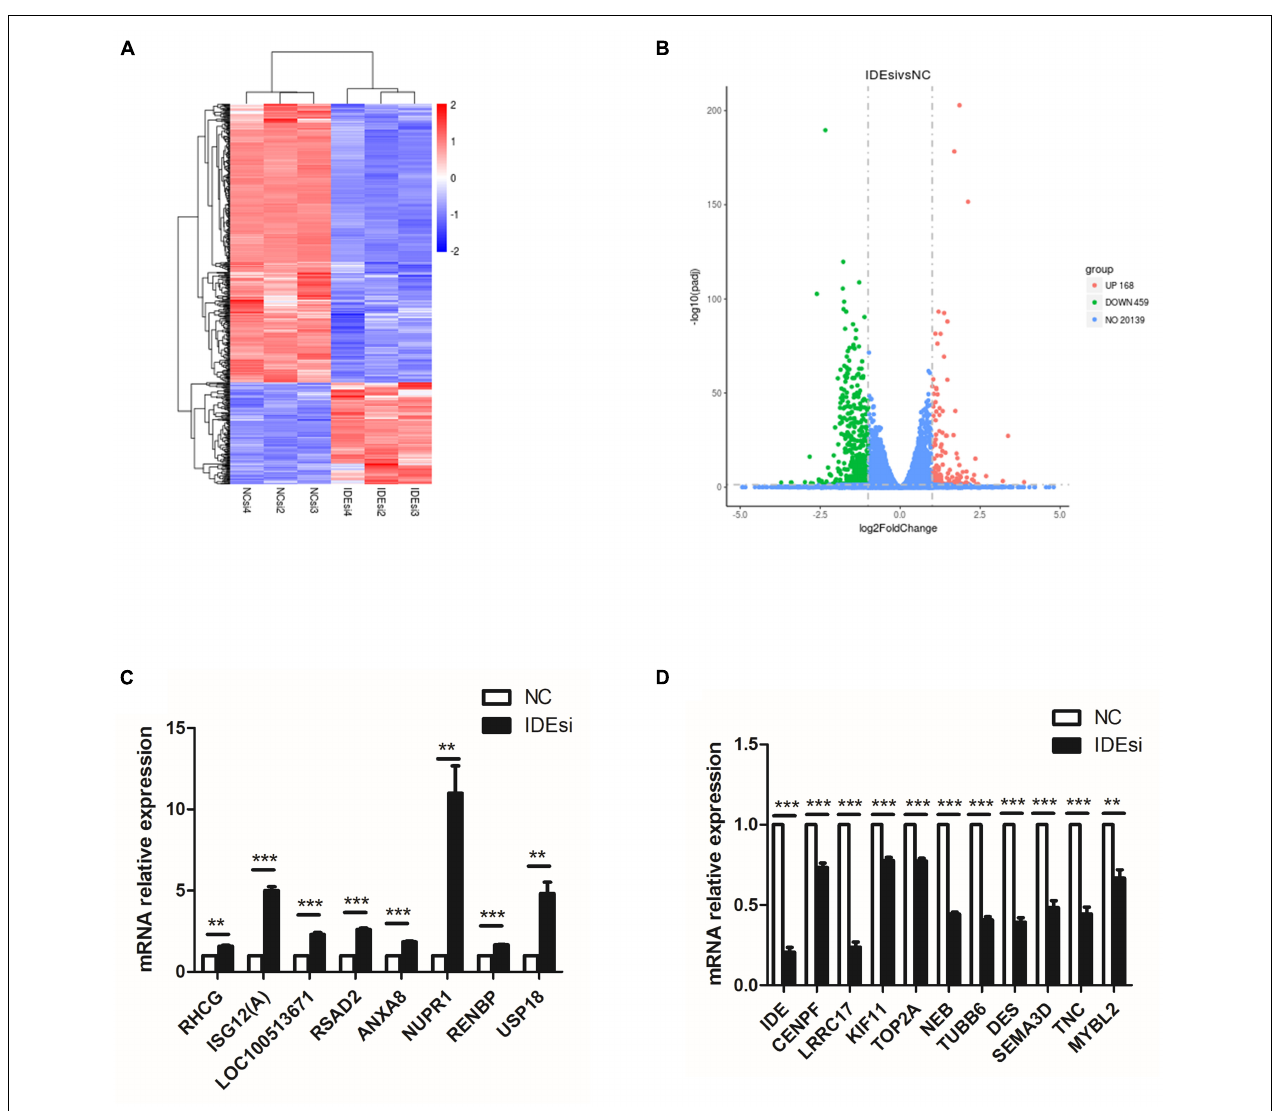
FIGURE 3 | RNA sequencing (RNA-seq) analysis identifies 627 differentially expressed genes (DEGs) with adjusted P < 0.05 and | log2 fold change| ≥ 1. (A) Heatmap of RNA-seq shows clusters of DEGs in the PSMSCs from IDEsi group and NC group. (B) The volcano plot shows 168 upregulated DEGs and 459 downregulated DEGs in IDEsi-transfected PSMSCs compared with NC-transfected PSMSCs. (C,D) The mRNA relative expression of randomly selected 8 upregulated DEGs (C) and 10 downregulated DEGs (D) from RNA-seq are confirmed by RT-qPCR assay. ** P < 0.01 and *** P <